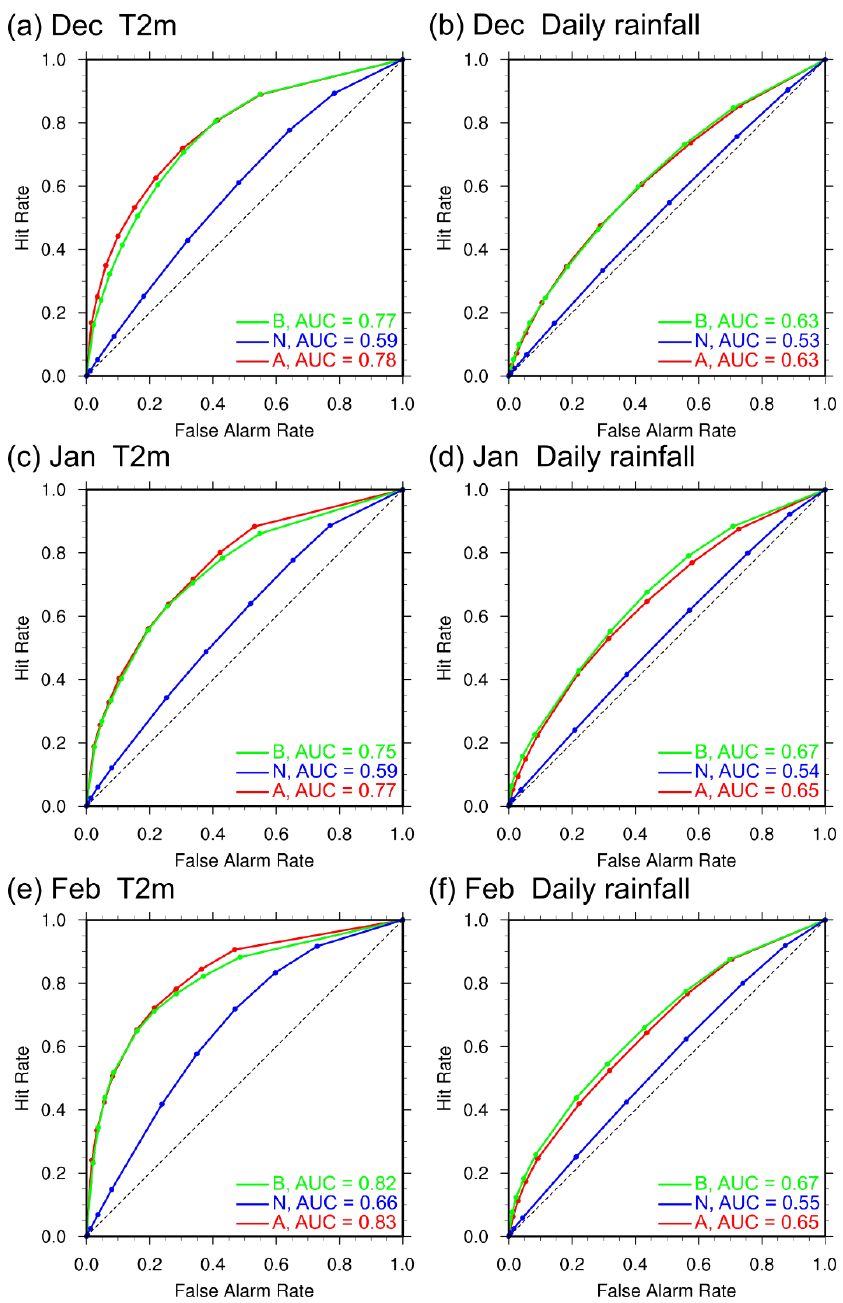
Figure 6. The relative operating characteristic curves (ROC) and the area under the ROC curve (AUC) for the three-category probabilities of monthly averaged T2m (left column) and averaged daily rainfall (right column) on ( a , b ) December, ( c , d ) January, and ( e , f ) February. Green, blue, red lines denote the below normal (B), near normal (N), and above normal (A) categories.